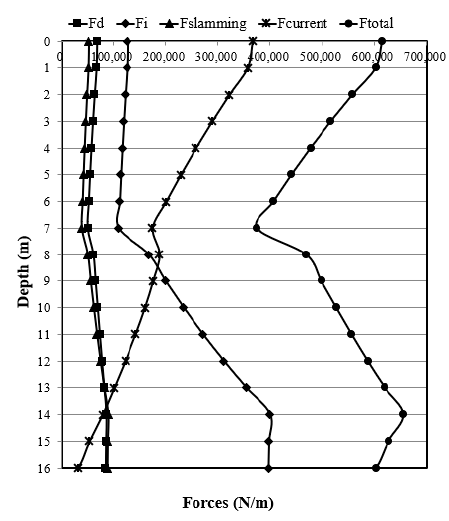
Figure 4. Distributions of wave and current forces.